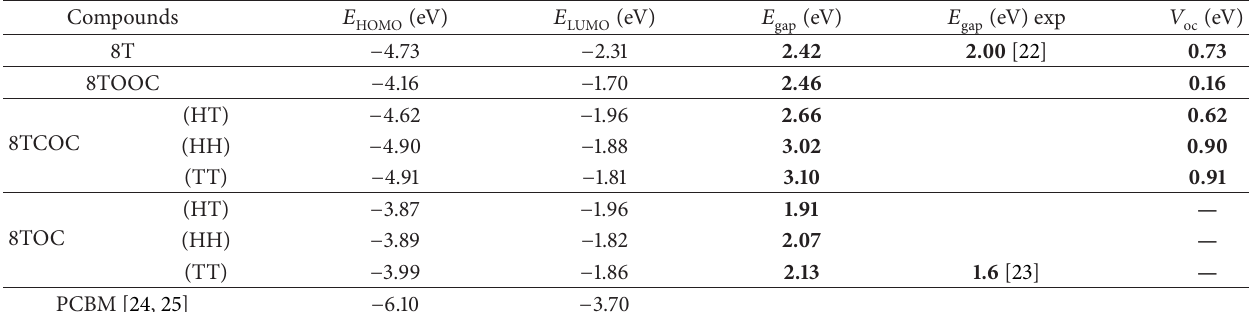
(eV), 𝐸 (eV), 𝐸 (eV), and the open circuit voltage 𝑉 gap LUMO HOMO